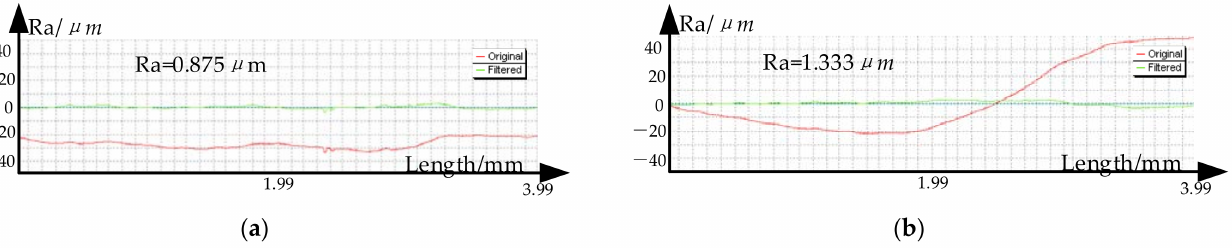
Figure 28. The roughness curves: ( a ) ψ = 5 ◦ and ( b ) ψ = 15 ◦